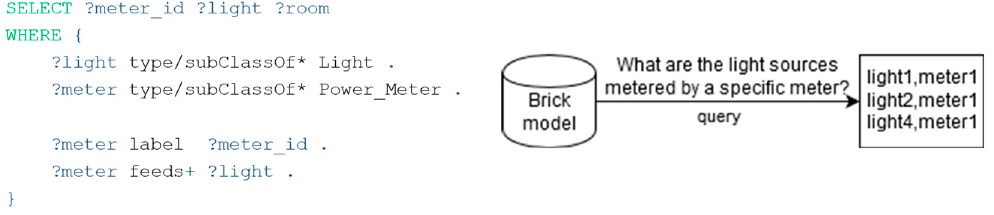
Figure 10. Query for collecting per meter light list.